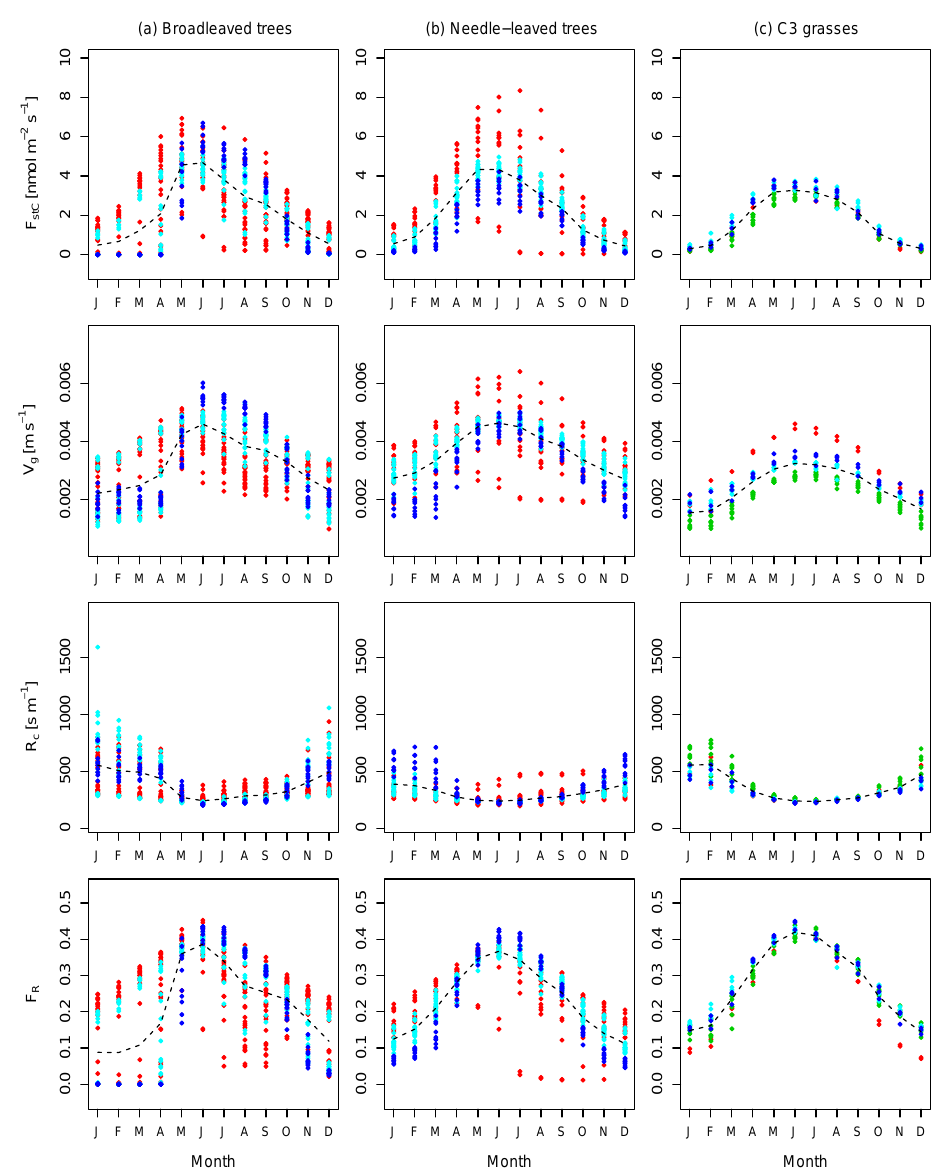
Figure A2. Simulated monthly mean values of O 3 uptake ( F stC ), O 3 deposition velocity ( V g ), O 3 surface resistance ( R c ), and the flux ratio ( F R ) for sites dominated by broadleaved trees (left column), needle-leaved trees (central column), and C 3 grasses (right column). The colour indicates the location of the site. Dark blue: Denmark, Sweden, and Finland; light blue: Germany, France, and Netherlands; green: Austria and Switzerland; red: Italy, Portugal, Spain, and Israel. Broken line: mean of all sites and years of the 12